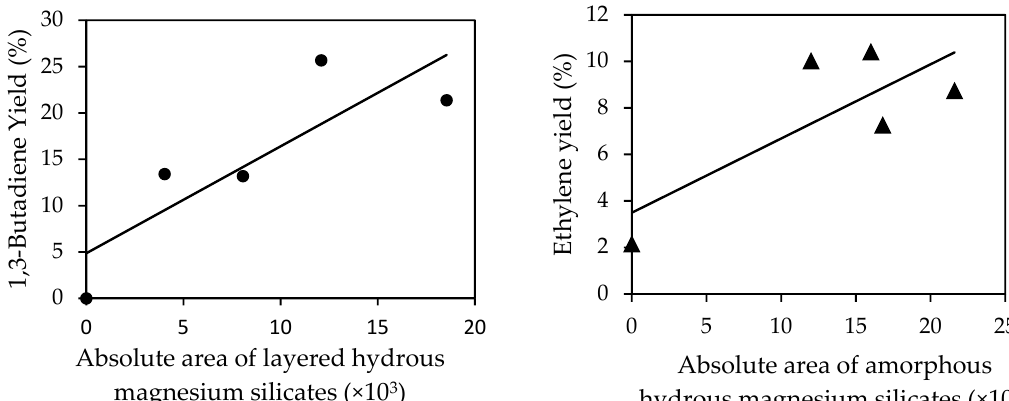
Figure 6. Direct correlations between 1,3-butadiene ( left ) and ethylene yield ( right ) and the absolute area detected by 1 H- 29 Si CP MAS-SSNMR spectroscopy for layered hydrous magnesium silicates ( left ) and amorphous hydrous silicates ( right ), respectively. The areas were determined by scaling the integrals of the corresponding peaks with the number of scans. The data point x = 0 is the MgO nano sample. Reprinted with permission from [27]. Copyright 2016, American Chemical Society.